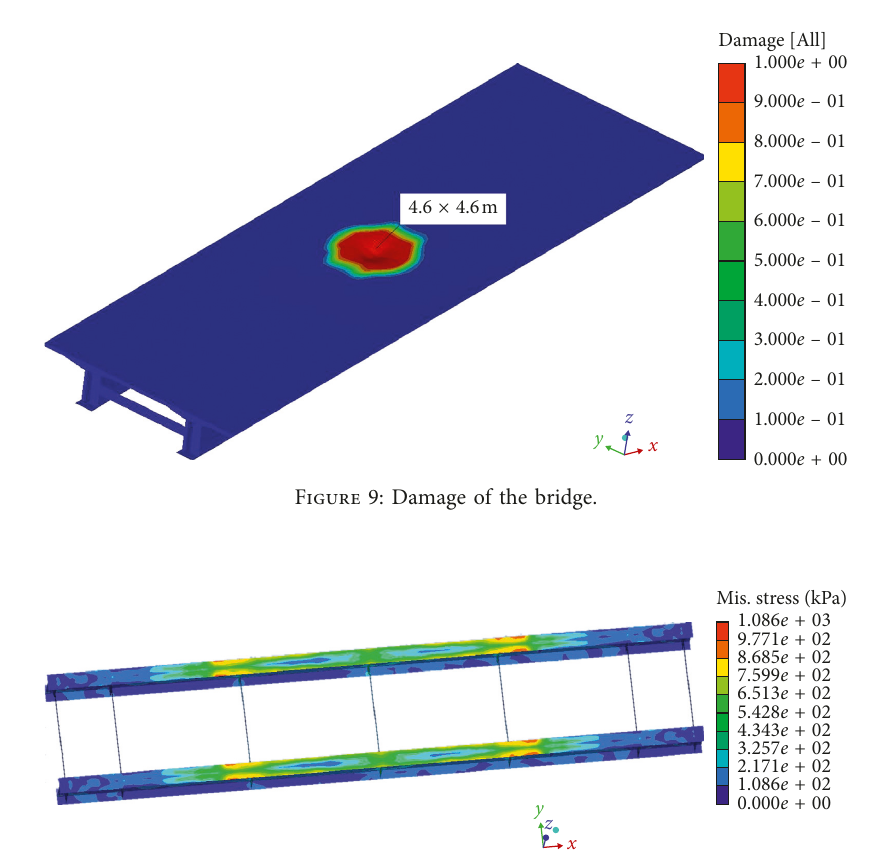
Figure 10: Stress distribution of I-shaped